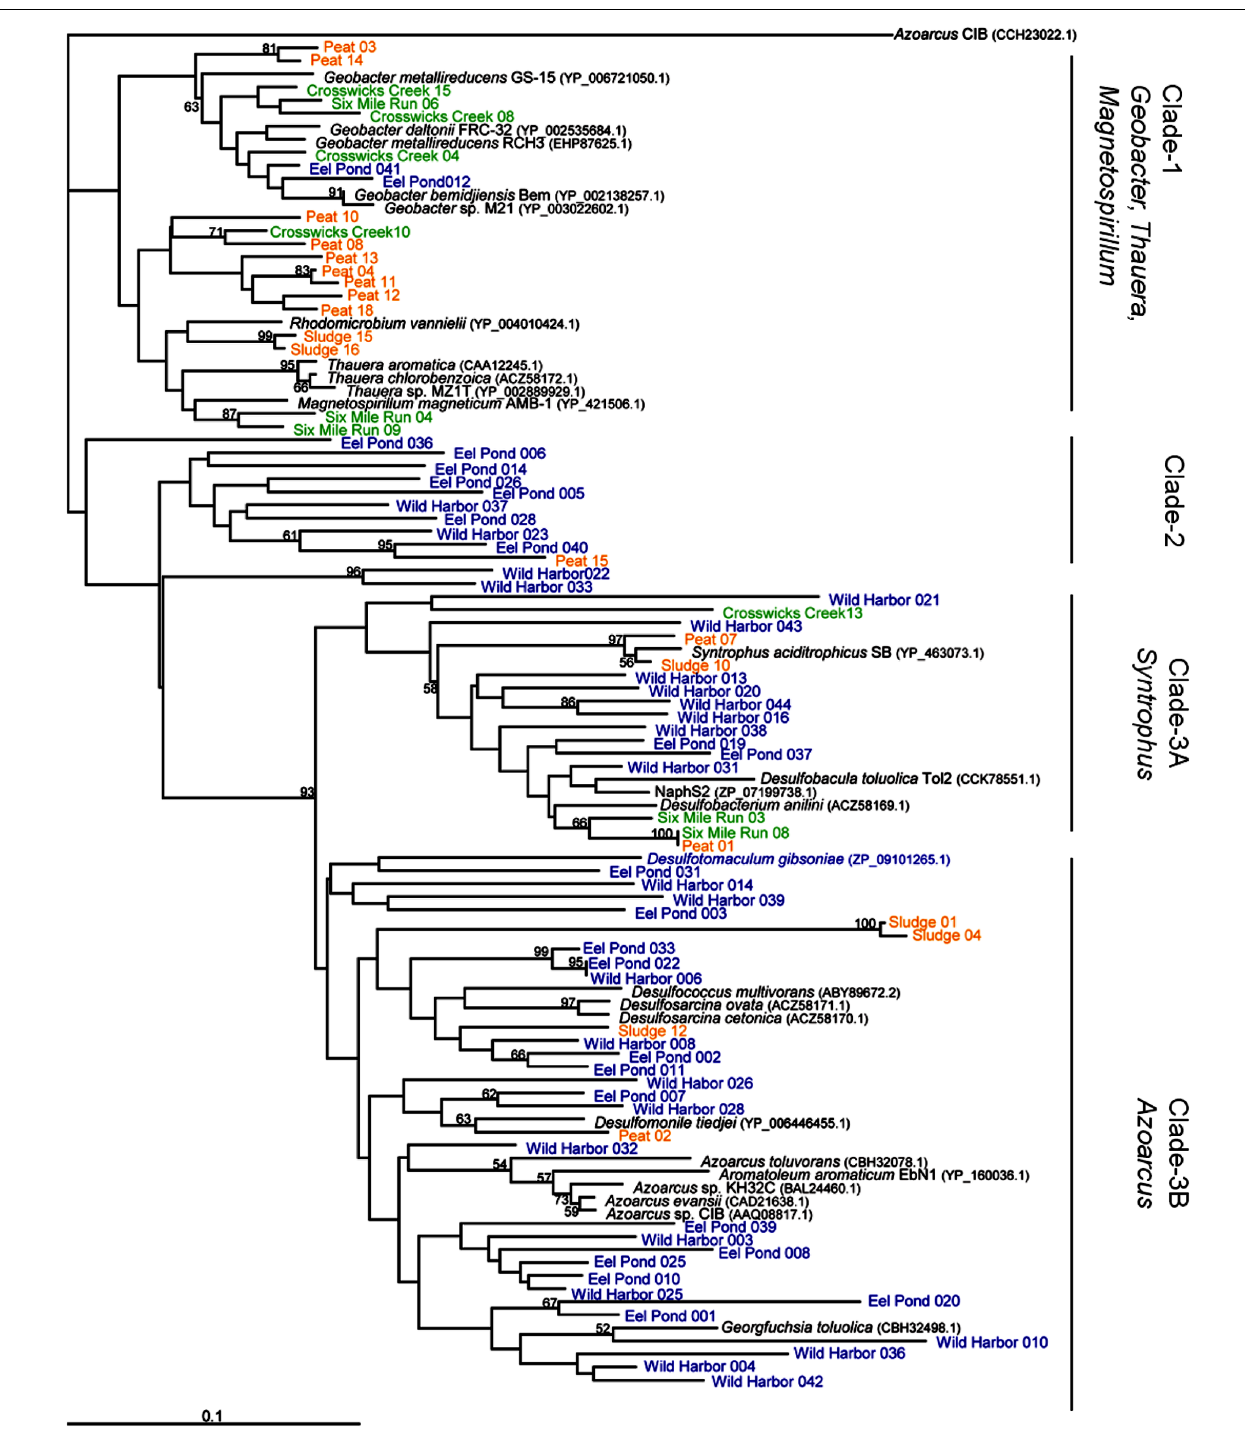
(Crosswicks Creek and Six Mile Run), and orange represents methanogenic sites (anaerobic digester and peat bog). Clade-1 contains genome sequences from Geobacter , Magnetospirillum , and Thauera sp. Clade-2 is unique to this study and only contains sequences from Eel Pond and Wild Harbor. Clade-3 has representatives from the Syntrophus (Clade-3A) and Azoarcus (Clade-3B) isolates, along with a several sulfate-reducing